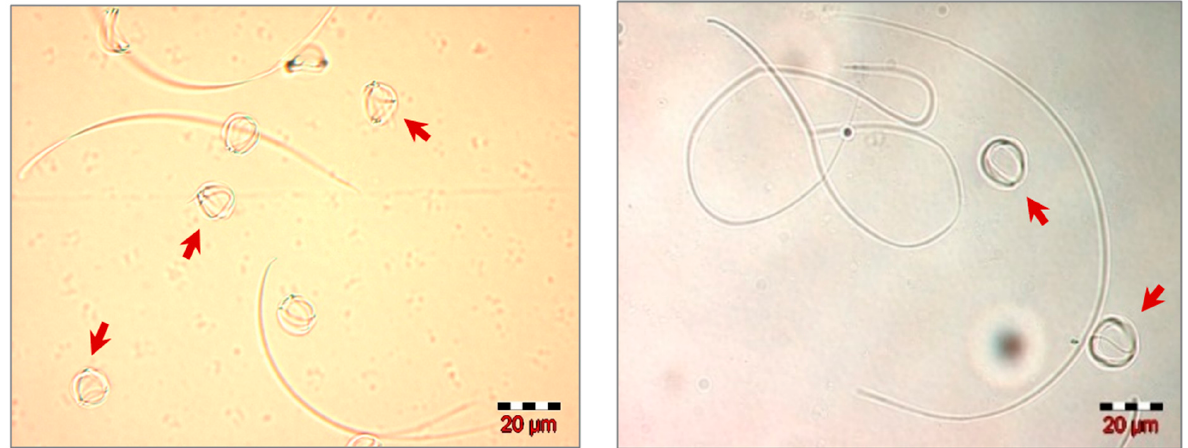
Figure 5. Morphological appearance of swollen (strongly coiled) honey bee drone spermatozoa.